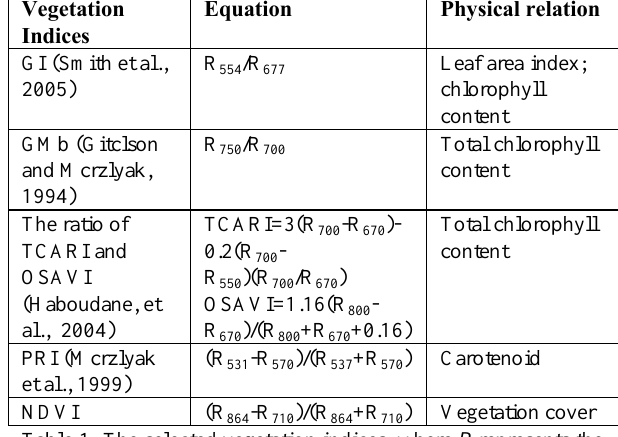
Table 1: The selected vegetation indices, where R represents the surface reflectance at the specific wavelength. For example, R 554 means the surface reflectance value of the pixel at the 554 nm.